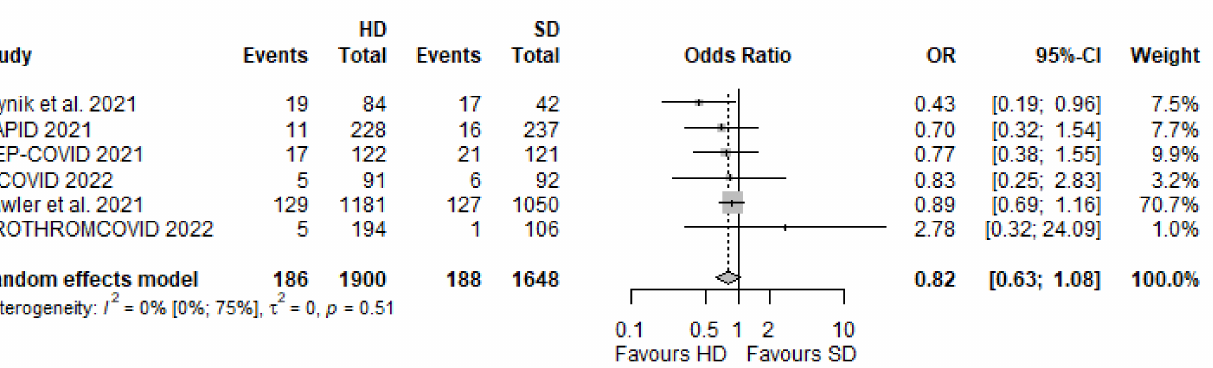
Figure 6. Need for invasive mechanical ventilation